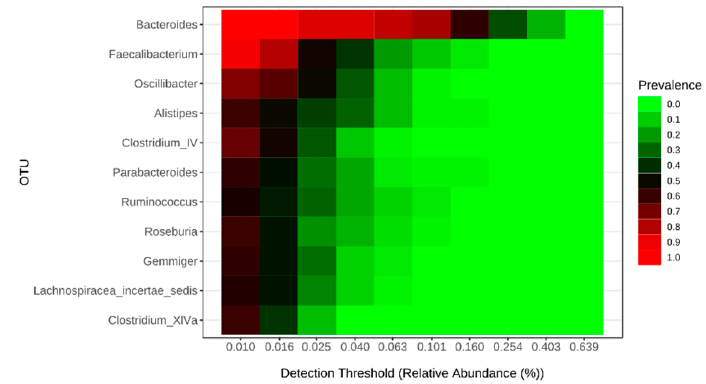
Figure 1. Core intestinal microbiome in children with and without ASD.